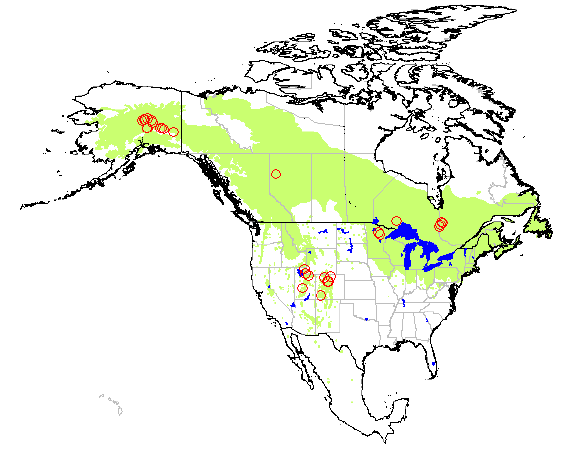
Figure 1. Geographic distribution of trembling aspen ( Populus tremuloides Michx.) and location of the study sites covered by this literature review.